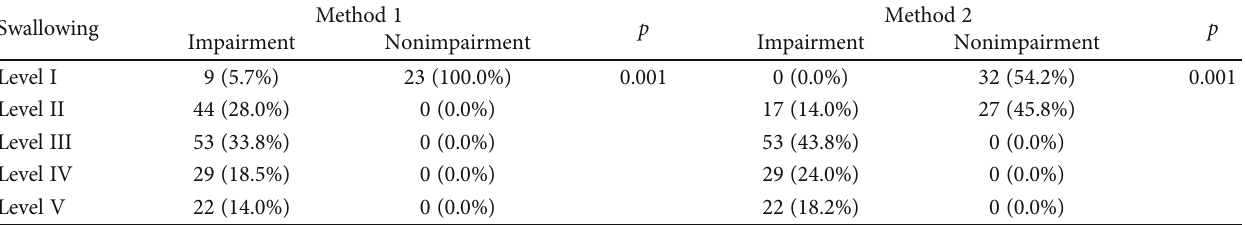
Table 4: Comparison of swallowing function between the cognitive impairment and nonimpairment groups according to two di ff erent MoCA cuto ff scores.